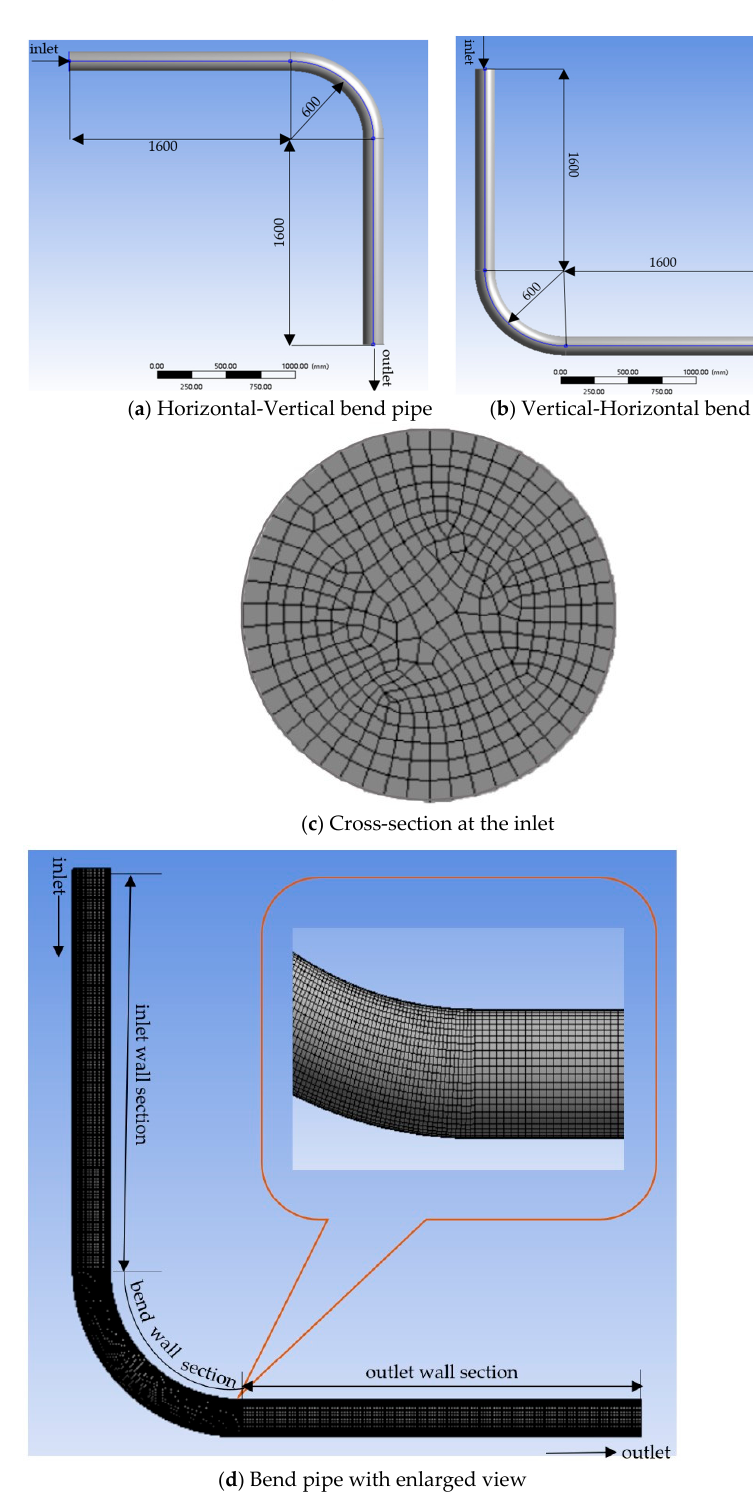
Figure 1. Geometry and meshing of bend pipe.